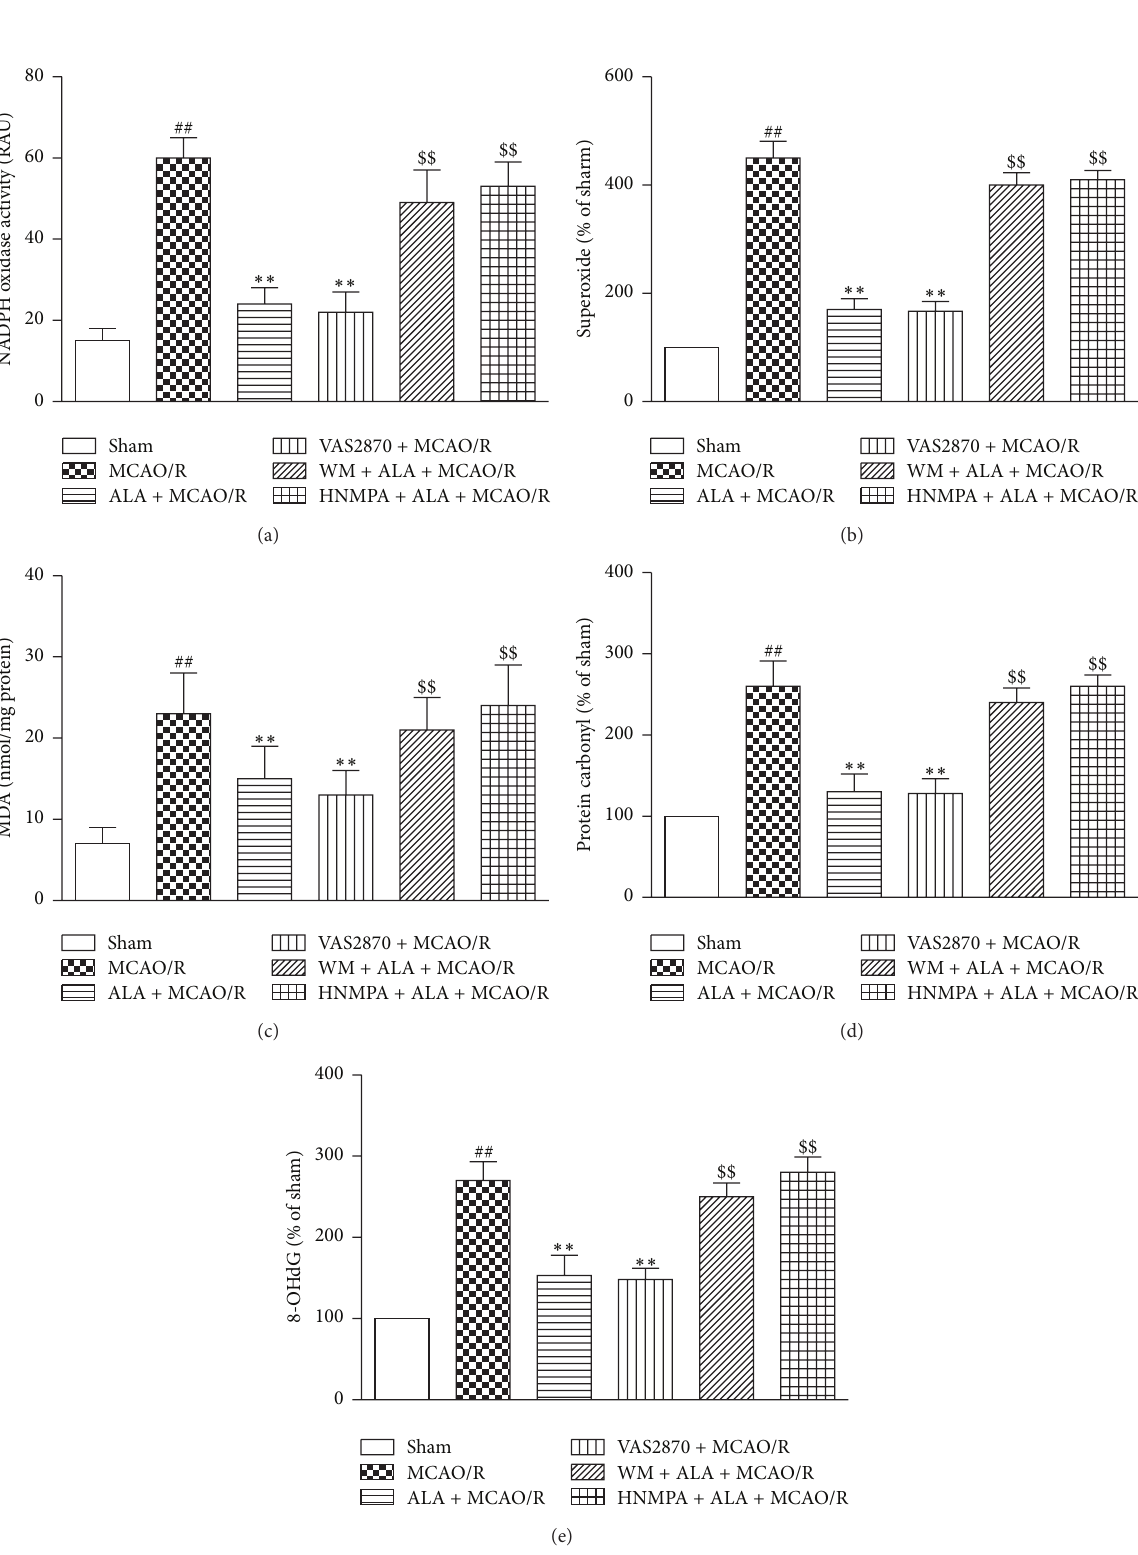
Figure4:ALAsuppressedMCAO/R-inducedoxidativestress.(a)ALAinhibitedMCAO/R-inducedupregulationofNADPHoxidaseactivity. (b) ALA suppressed MCAO/R-induced superoxide generation and the increment of oxidative stress indicators including MDA (c), protein carbonyl (d), and 8-OHdG (e). For the ALA + MCAO/R group, ALA (40mg/kg, i.p.) was daily administered to rats for 3 days. For the sham and MCAO/R groups, the rats were given the same amount of ethanol. Data were expressed as means ± SEM. ## 𝑃 < 0.01 compared with the sham group. ∗∗ 𝑃 < 0.01 compared with the MCAO/R group. $$ 𝑃 < 0.01 compared with the ALA + MCAO/R